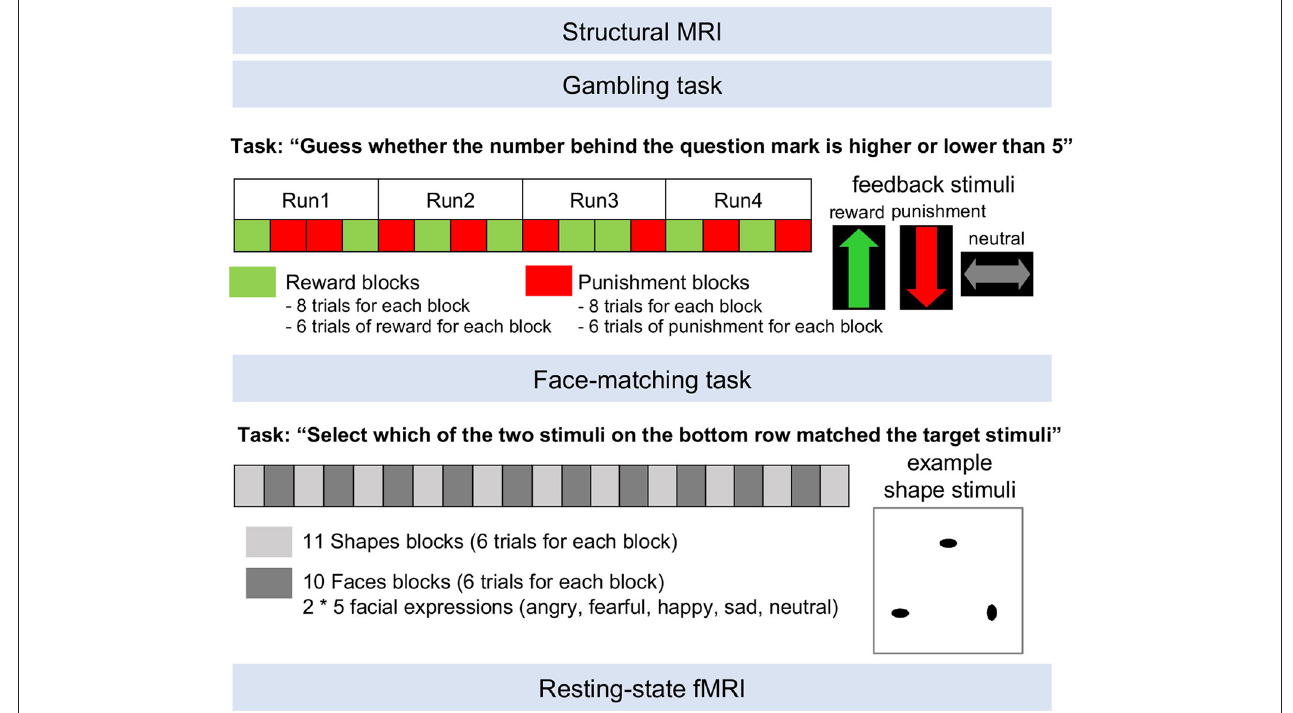
FIGURE 3 | MRI data acquisition procedure. After structural images were acquired, functional images were acquired during a gambling task, face-matching task, and resting-state. The gambling task consisted of counterbalanced presentation of reward and punishment blocks. The face-matching task consisted of counterbalanced presentation of shapes and faces blocks. Feedback stimuli for the gambling task and an example shape stimulus for the face-matching task are presented. During the resting-state fMRI scan, participants were instructed to let their minds